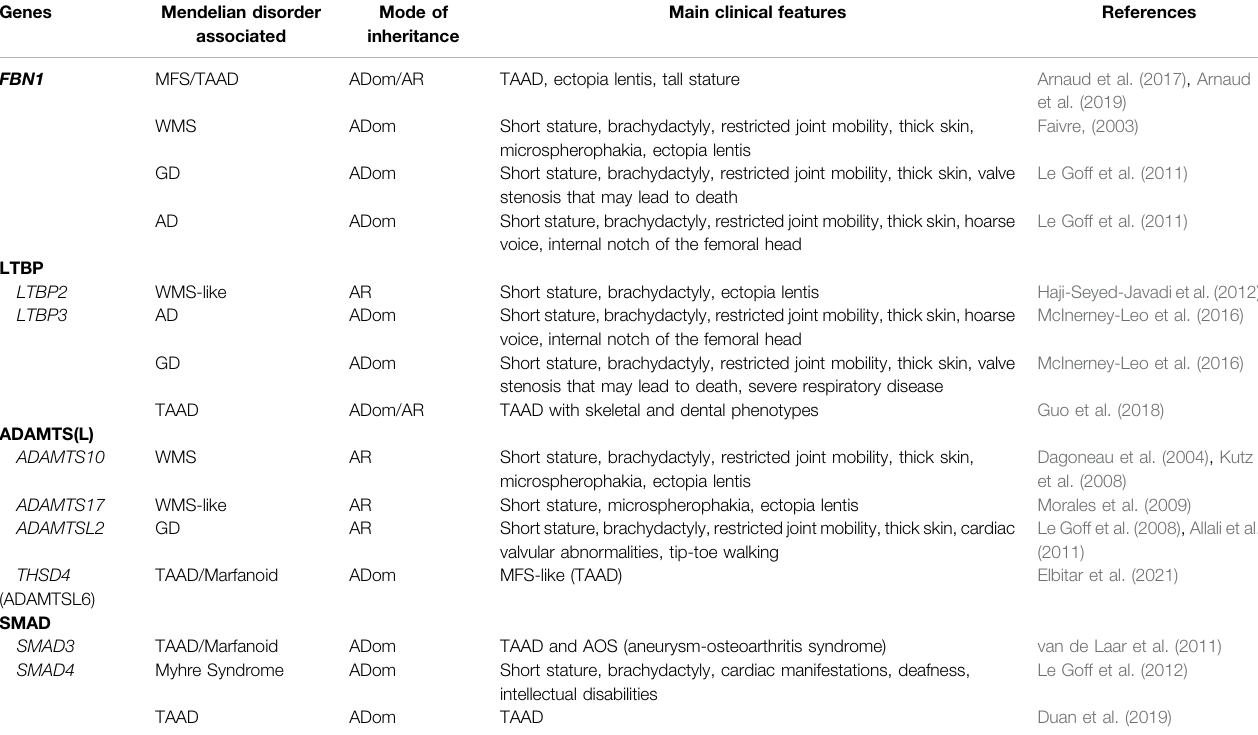
TABLE 1 | Genes and disorders associated. This table gathers together all pathologies associated with FBN1 and ADAMTS (-L) proteins mentioned in this review. AD: acromicric dysplasia, ADom: autosomal dominant, AR: autosomal recessive, GD: geleophysic dysplasia, MFS: Marfan syndrome, TAAD: thoracic aortic aneurysm and dissection, WMS: Weill Marchesani